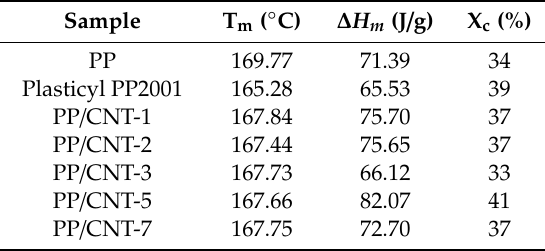
Plasticyl PP2001 and PP / CNT composites as determined during the first heating.